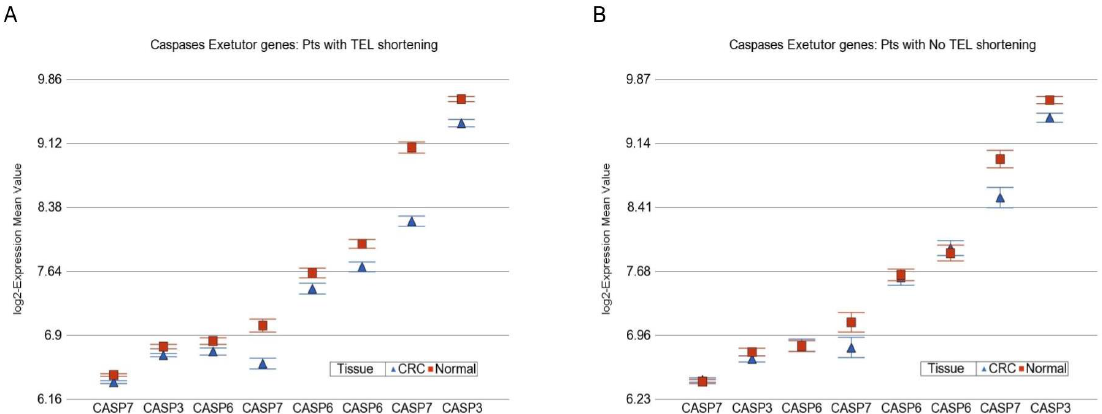
Figure 6. Differential gene expression of caspase executor genes in CRC tissue (in blue) compared to corresponding normal tissue (in red). The gene probes (multiple probes for some genes) are shown on the x-axis, and the Log 2 -transformed expression value is shown on the y-axis. Data from patients with RTL shortening are shown on the left ( A ), and data from patients without RTL shortening are shown on the right ( B ). The average magnitude of downregulation was significantly more ( p = 1.34 × 10 − 6 ) if the patient had telomere shortening ( − 1.24-fold (95% CI − 1.20 to − 1.28), shown in ( A )) compared to those without telomere shortening ( − 1.06-fold (95% CI − 1.12 to − 1.01), shown in ( B )).